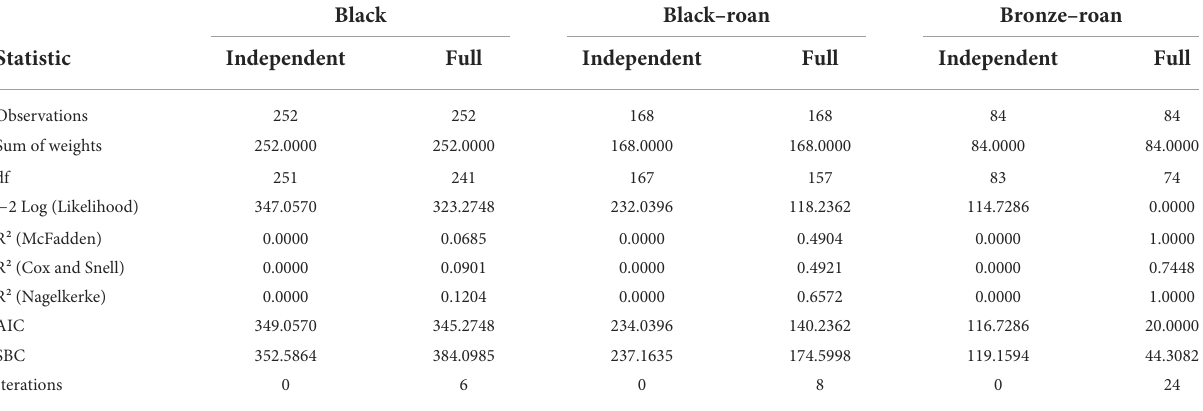
TABLE 2 Goodness of fit statistics for each Andalusian turkey